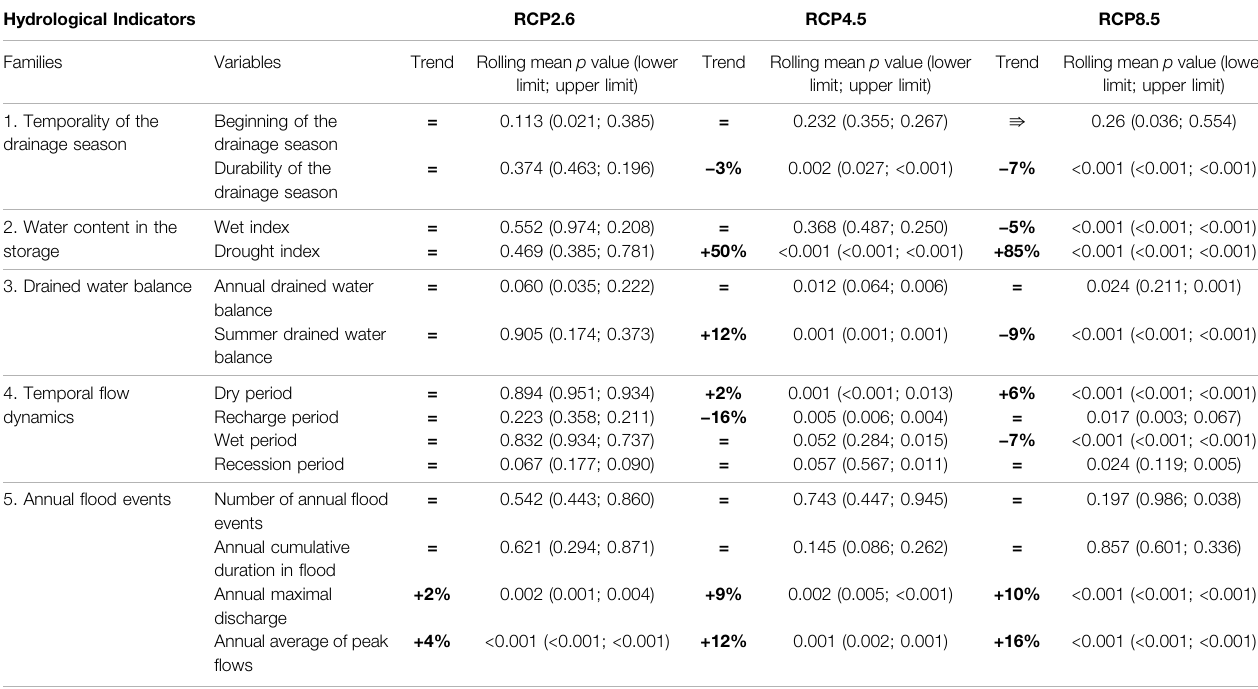
TABLE 6 | Results of Mann – Kendall tests regarding the trends from the fi rst fi ve HI classes —“ Temporality of the drainage season ” , “ Water content in the storage ” , “ Drained water balance ” , “ Temporal fl ow dynamics ” and “ Annual fl ood events ” in the projected future per RCP. Per HI, the p value corresponding to the rolling mean was supported bythe pvalues fromthe testson thecon fi dence interval(lowerlimit; upper limit).Thetrends werede fi ned astherelative deviationbetween ameanhistorical value from 1975 – 2004 and a mean future value from 2071 – 2099. Only trends with signi fi cant p values were calculated. Hydrological